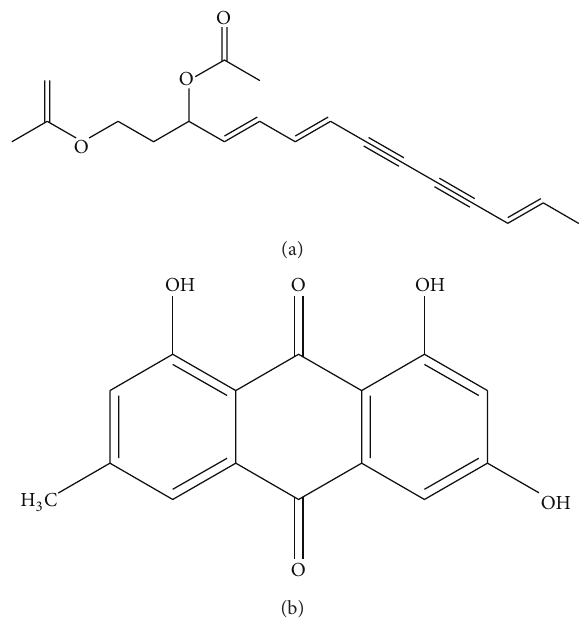
Figure 1: Chemical structures of (4 E ,6 E ,12 E )-tetradecatriene-8,10- diyne-1,3-diyl diacetate (a) and Emodin